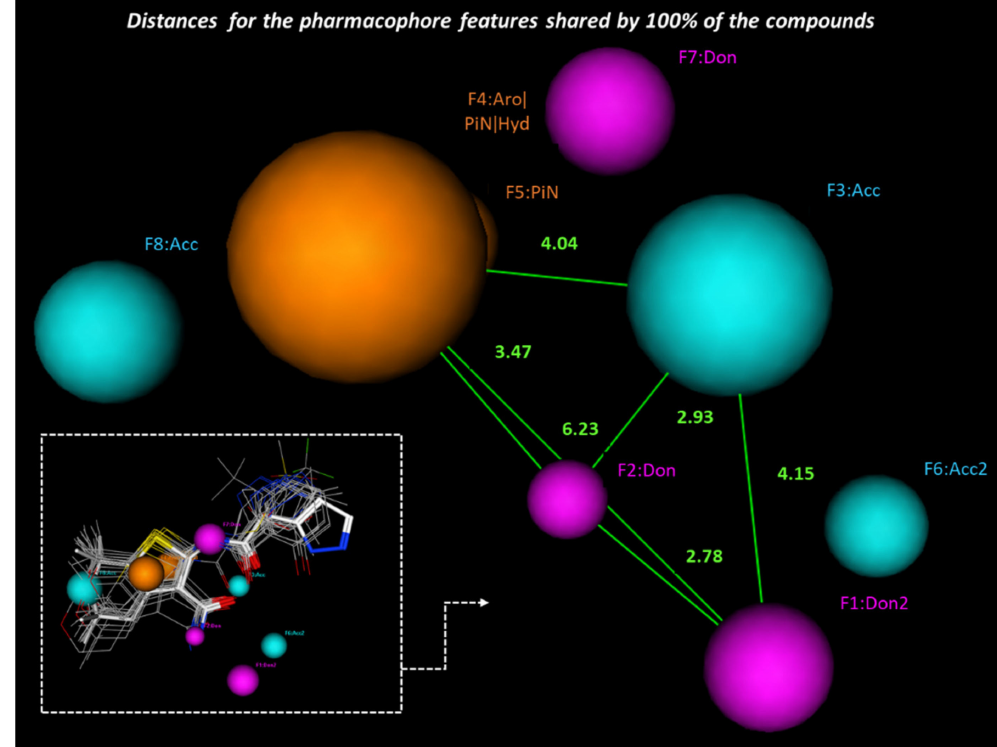
Figure 13. Most relevant pharmacophore features experienced and related distance by the thienoderivatives 1 – 26 , acting as CFTR